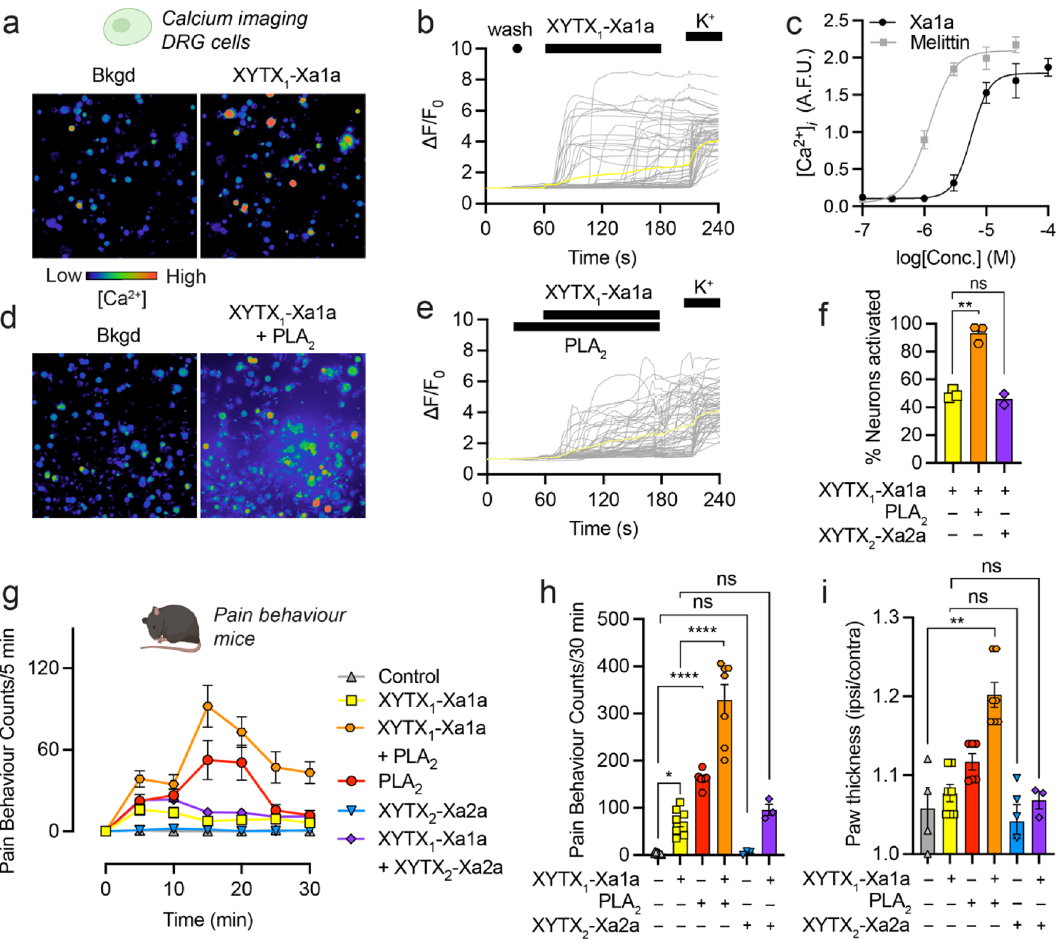
Figure 5. Pain-causing effects of X. aruana venom components. ( a,b ) Application of XYTX 1 -Xa1a (10 μM) to DRG cells produced an immediate and sustained, non-cell-specific increase in [Ca 2+ ] i . ( c ) Potency of XYTX 1 - Xa1a and melittin in F11 cells, as monitored by changes in [Ca 2+ ] i . ( d–f ) The increase in [Ca 2+ ] i caused by XYTX 1 -Xa1a was potentiated by the presence of venom PLA 2 (1 µM), but not XYTX 2 -Xa2a (1 μM). ** P < 0.01 (unpaired t -test). ( g,h ) Shallow intraplantar injection of XYTX 1 -Xa1a (200 pmol) caused spontaneous pain behaviours in mice which was potentiated by co-injection of venom PLA 2 (20 pmol), but not XYTX 2 -Xa2a (20 pmol). XYTX 2 -Xa2a (20 pmol) alone does not cause spontaneous pain behaviours while venom PLA 2 does (20 pmol). Data are expressed as mean ± SEM ( n = 3–6). ( i ) Co-injection of XYTX 1 -Xa1a (200 pmol) plus venom PLA 2 (20 pmol) caused paw swelling. Data are expressed as mean ± SEM ( n = 3–6). * P < 0.05; ** P < 0.01; **** P < 0.0001 (one way-ANOVA with Tukey’s multiple